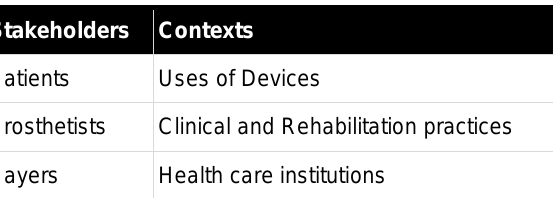
Table 1: Stakeholders and contexts in Health Economic Framing.